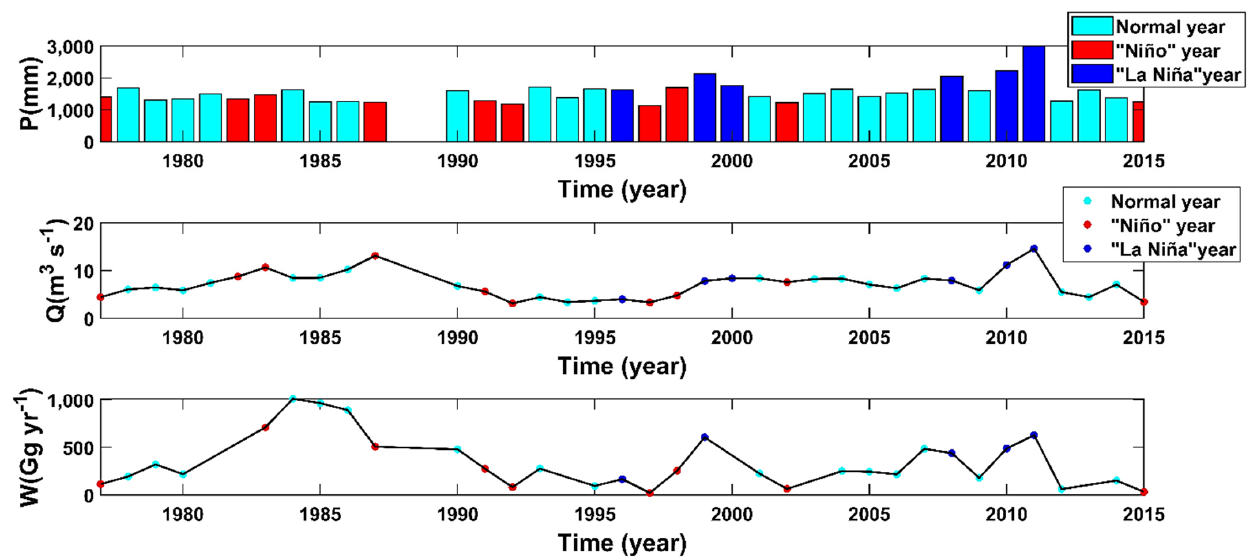
Figure 3. Measured annual rainfall, P, discharge, Q, and sediment load, W , in the Tonusco watershed, at La Galera gauging station. Color codes indicate normal, El Niño and La Niña years.